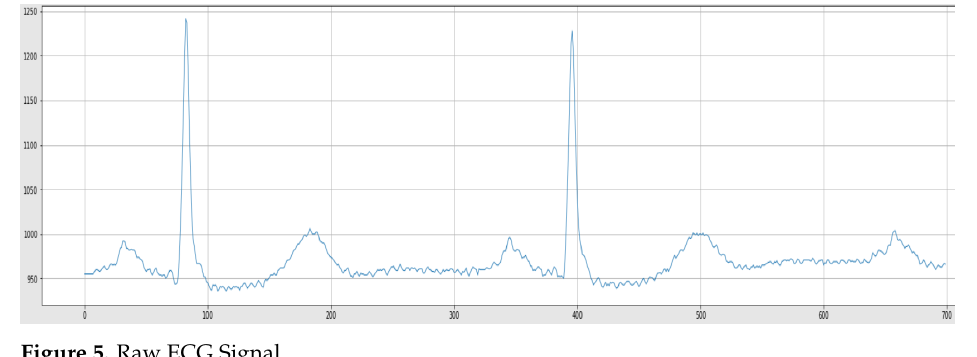
Figure 5. Raw ECG Signal.